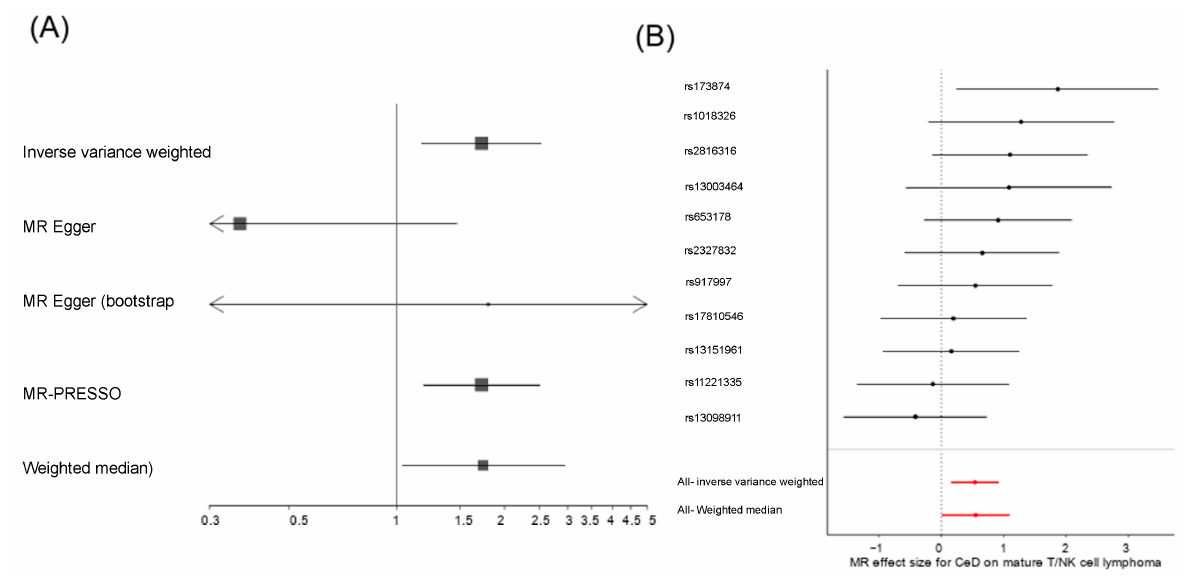
Figure 1. ( A ) Forest plot of the causal relationship effect of CeD and ( B ) Wald-ratio test of the effect of each CeD IV on mature T/NK cell lymphomas.